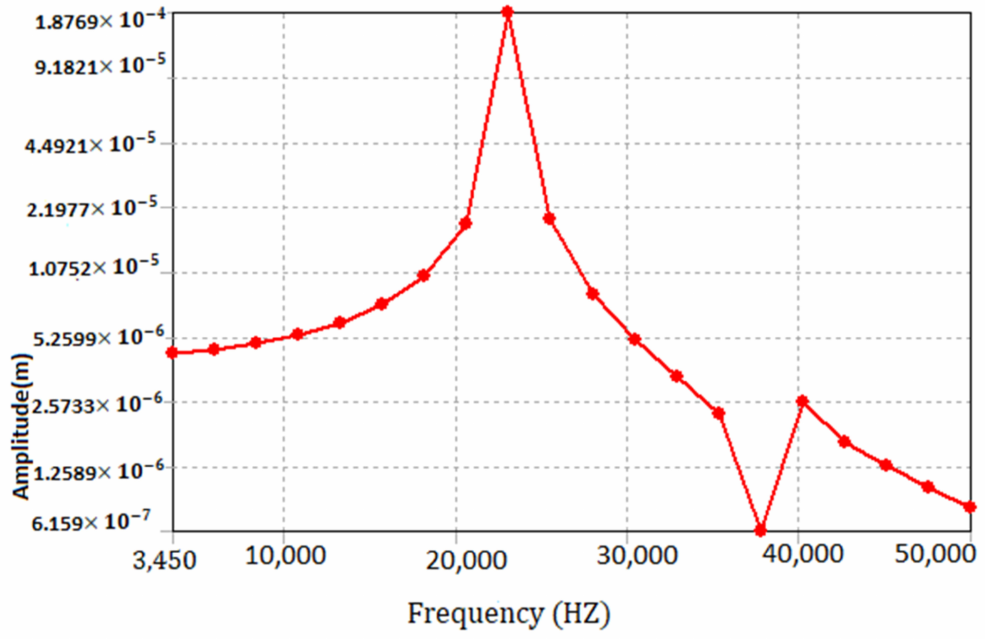
Figure 16. Frequency vs. amplitude graph of the face.